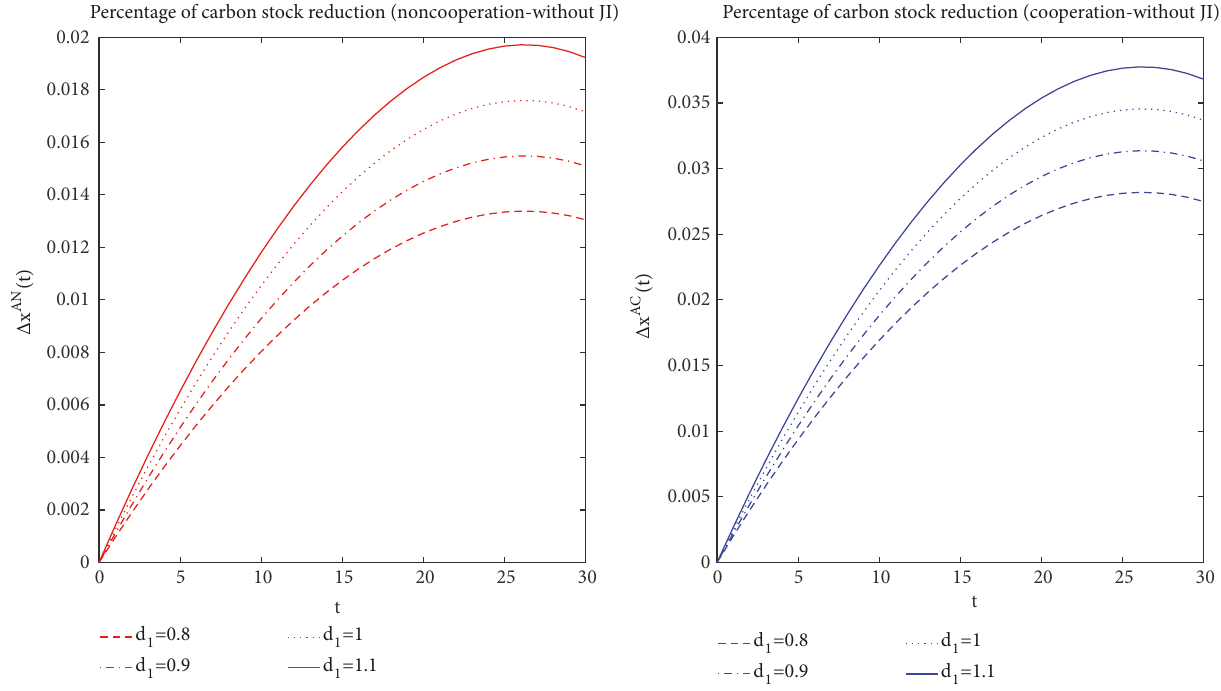
Figure 4: The behavior of percentage of carbon stock reduction as 𝑑 1 changes.